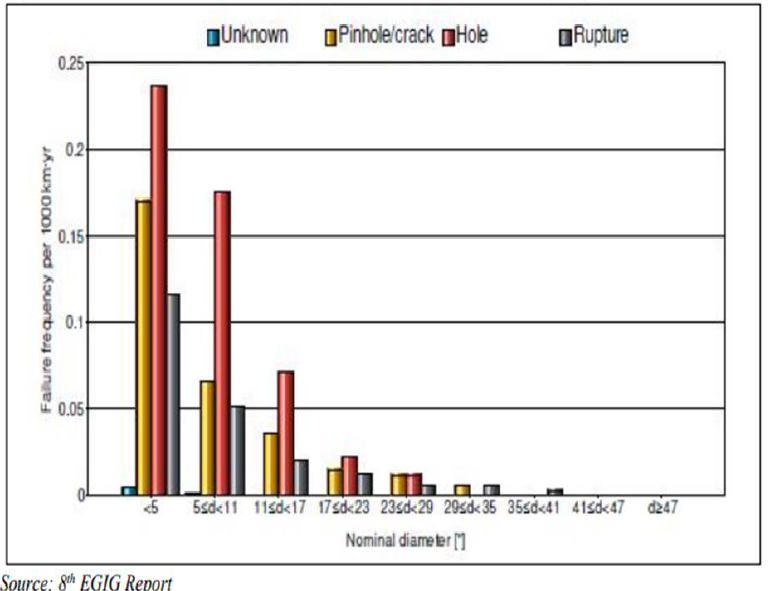
Figure 6. External failure frequency — relation with damage type and diameter class.